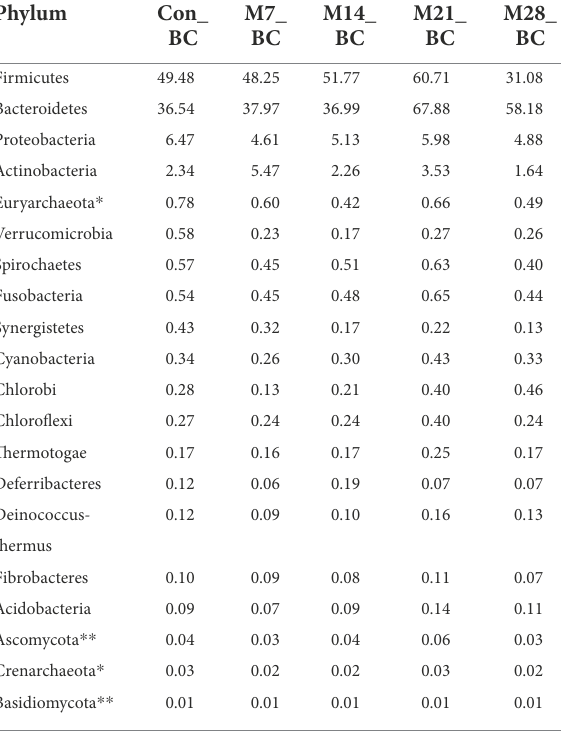
TABLE 1 Relative abundance (%) of the dominant phyla (top 20) in caecum digesta samples from broiler chickens fed with diets containing different levels of marama bean meal.